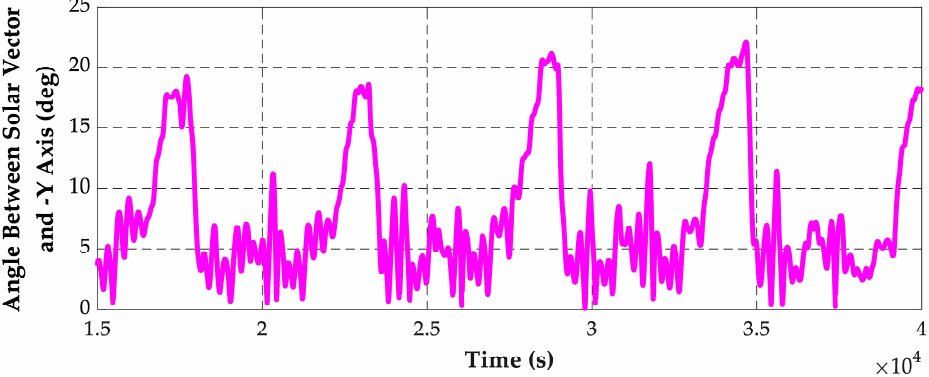
Figure 8. Angle between the solar vector and the − O b Y b